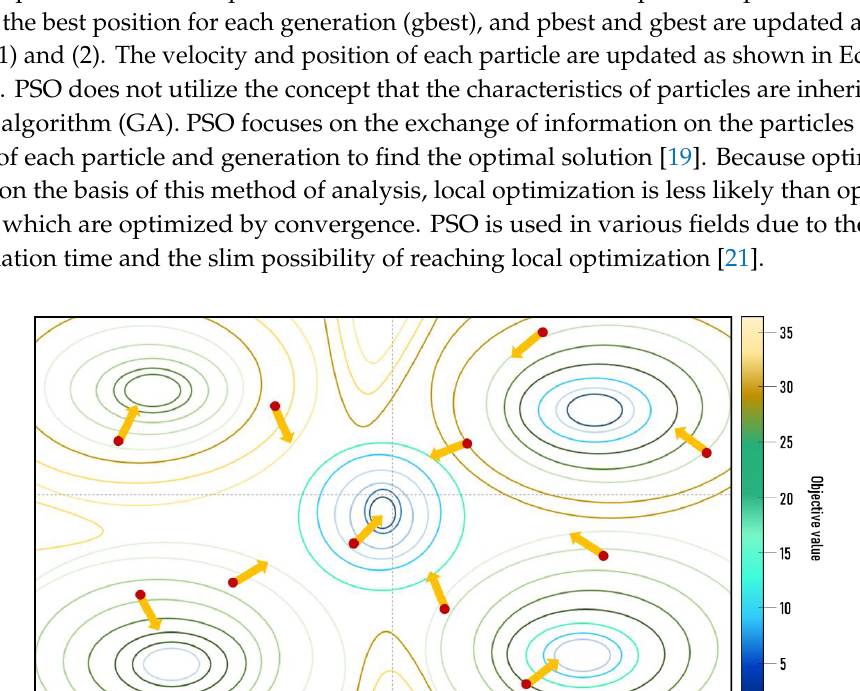
Figure 13. Particle swarm optimization (PSO) algorithm.